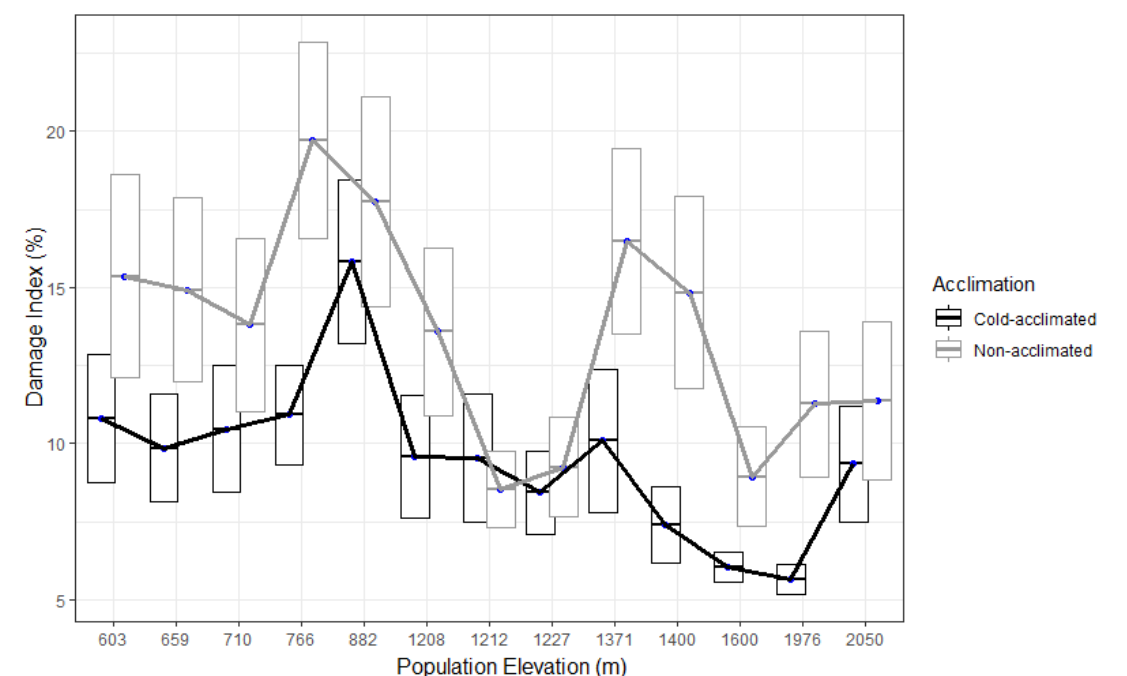
Figure 1. Interaction effects between test temperature (5, − 5, − 10, − 15, and − 20 °C) and acclimation treatment on the damage index (%) of samples averaged across koa population elevations (from 603 m to 2050 m). Each box represents the mean (±SE, standard error) damage index (%). Black dashes inside the boxes represent the means.